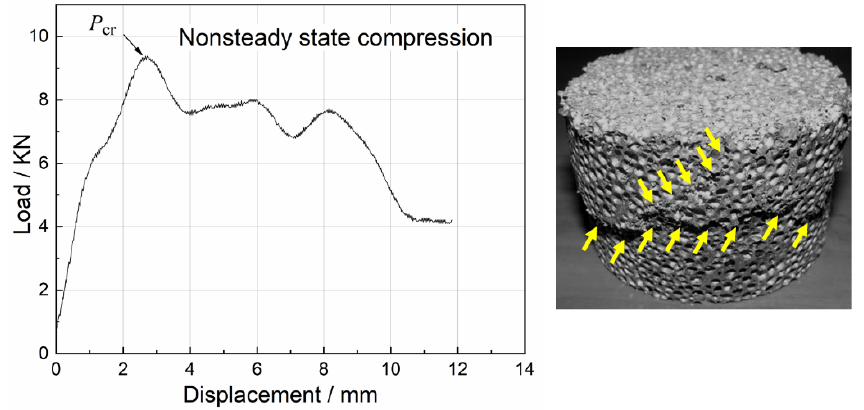
Figure 10. Load–displacement curve for nonsteady state compression and damaged.